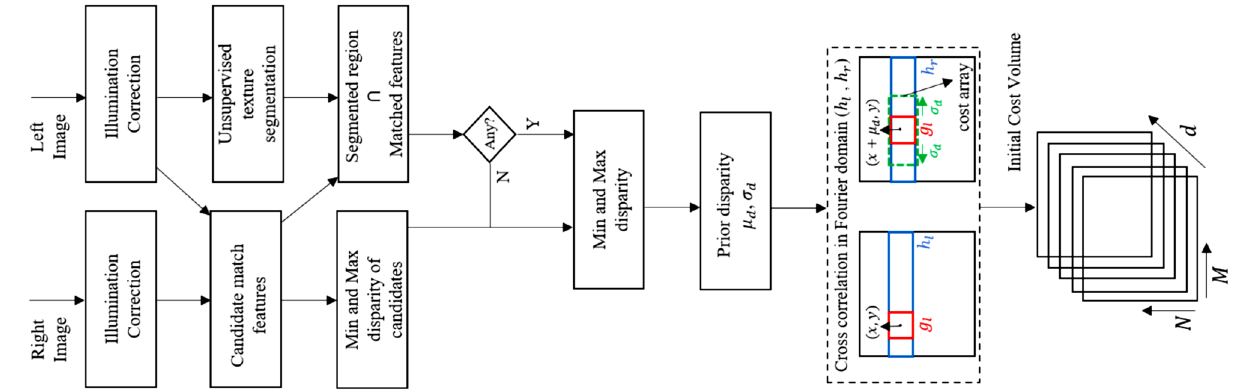
Figure 3. Schematic representation of sparse cost volume